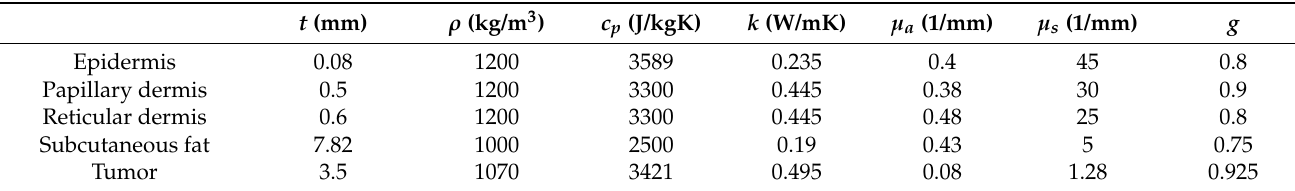
Figure 5. Schematic of numerical model. Table 4. Depth and thermal and optical properties of the skin layers and tumor